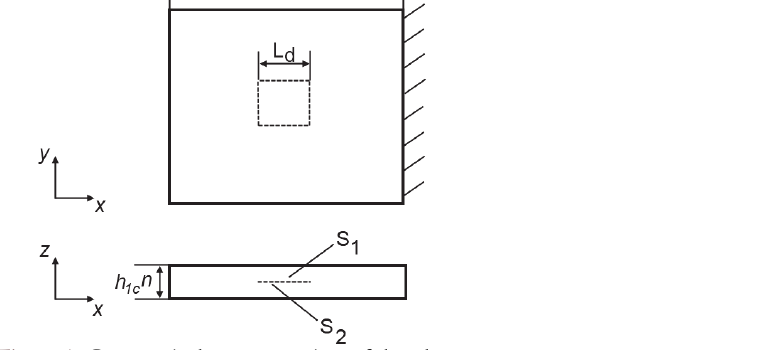
Figure 1: Geometrical representation of the